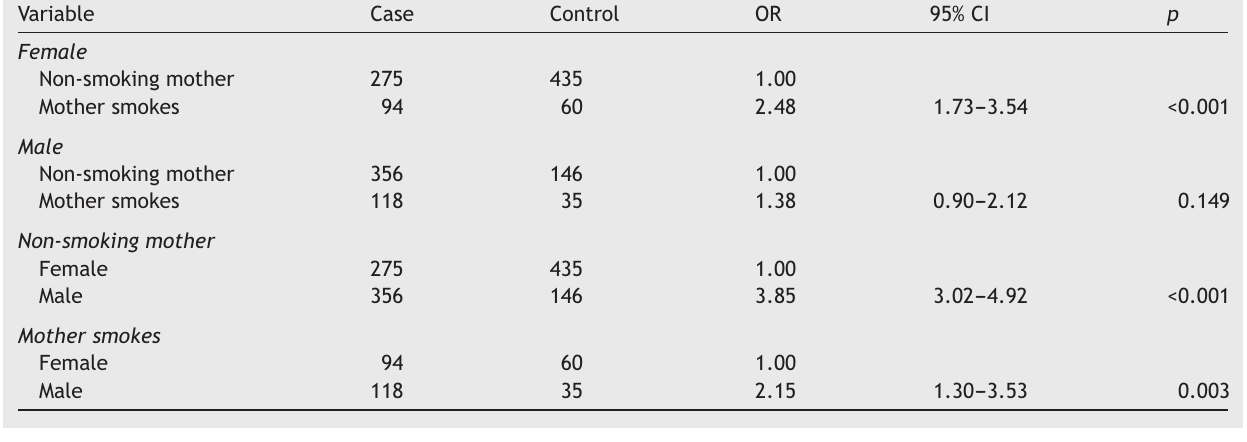
Table 2 Analyses of the association between maternal smoking and the occurrence of nonsyndromic cleft lip and/or palate in each gender separately, as well as association between gender and the occurrence of clefts in relation to maternal smoking.